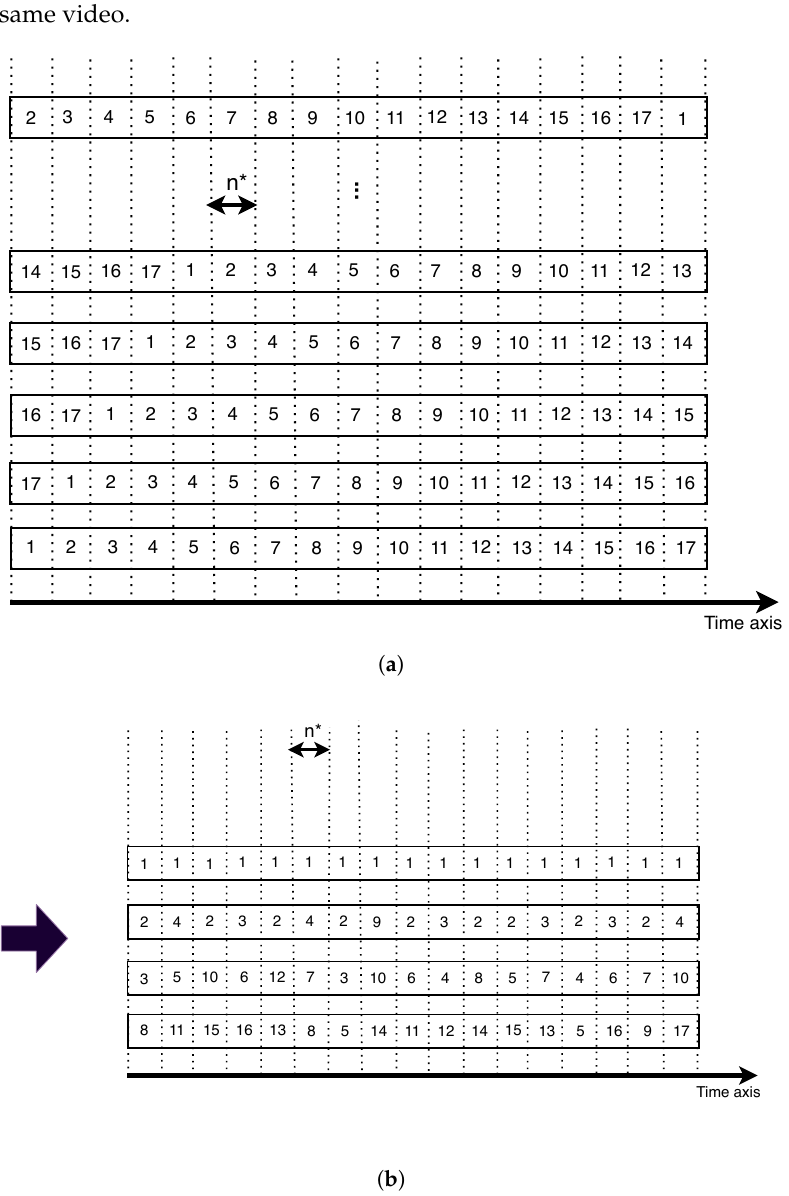
Figure 7. From proactive SASST to optimal scheduling of 17 segments. ( a ) SASST as SB; ( b ) Optimal Scheduling with 17